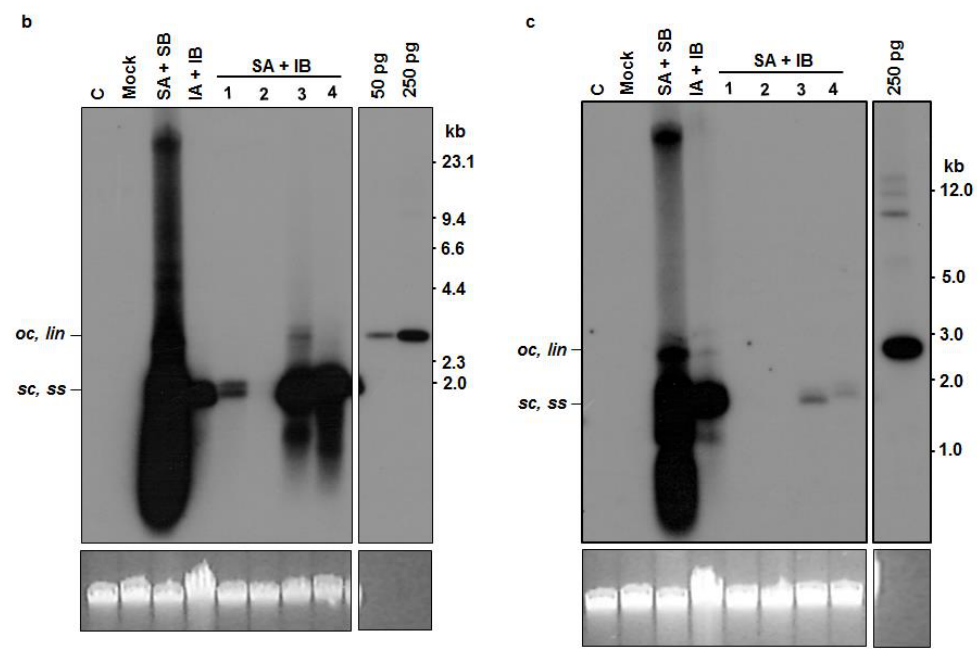
Figure 5. Pseudo-recombination in N. benthamiana with SLCMV-[SeM] DNA A and ICMV-[SeT4] DNA B. ( a ) Symptoms in N. benthamiana mock inoculated plants (Mock) and plants agroinoculated with the partial dimers of SLCMV-[SeM] DNA A + DNA B, ICMV-[SeT4] DNA A + DNA B and SLCMV-[SeM] DNA A + ICMV-[SeT4] DNA B. ( b ) Southern blot analysis using SLCMV-[SeM] DNA